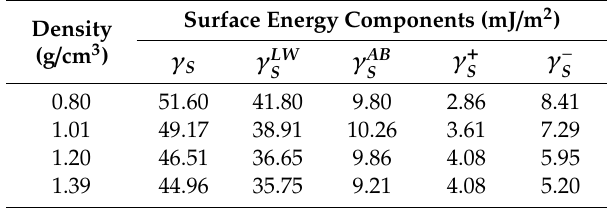
Table 1. Surface free energy of scrimbers with varying density.